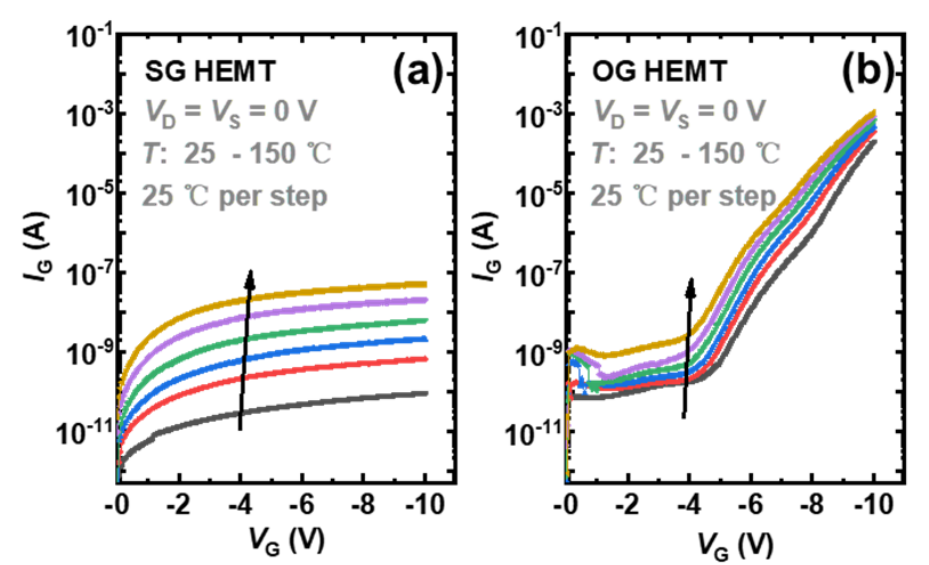
Figure 9. Gate leakage current of p-GaN gate devices under various temperatures: ( a ) SG HEMT, ( b ) OG HEMT.